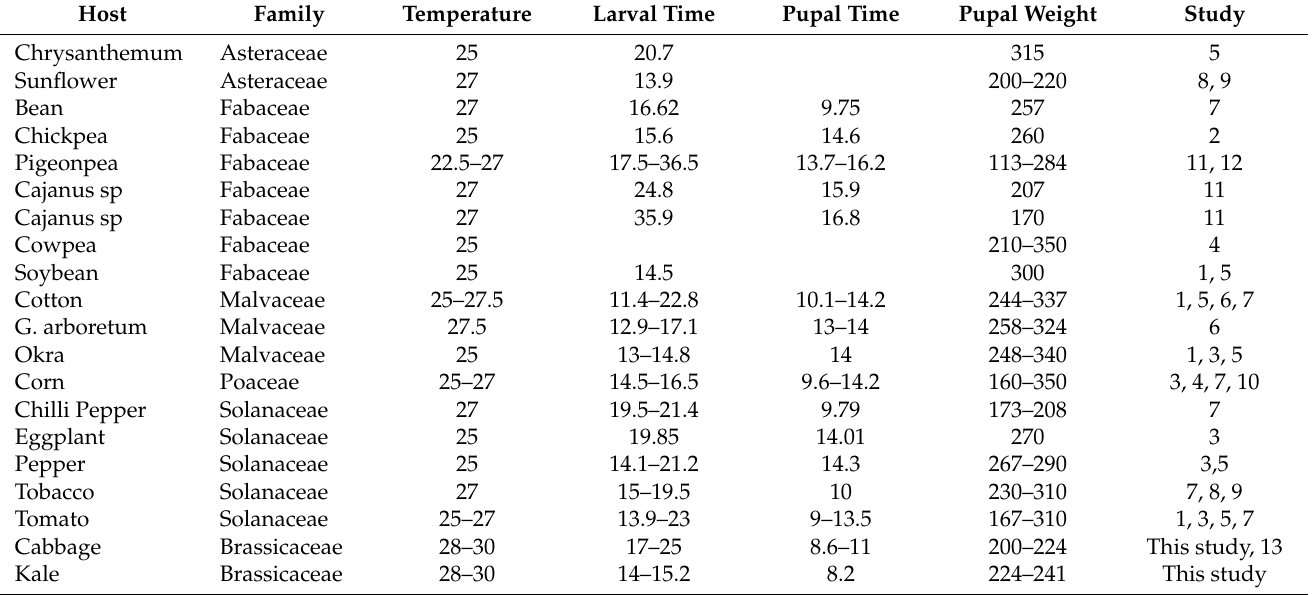
Table 3. Performance measures (Larval development time in days, Pupal development time in days and Pupal weight in mg) of Helicoverpa armigera on a range of host plants under laboratory conditions at a range of temperatures ( ◦ C). For multiple studies, we report the range in mean values and just the mean if only one study could be